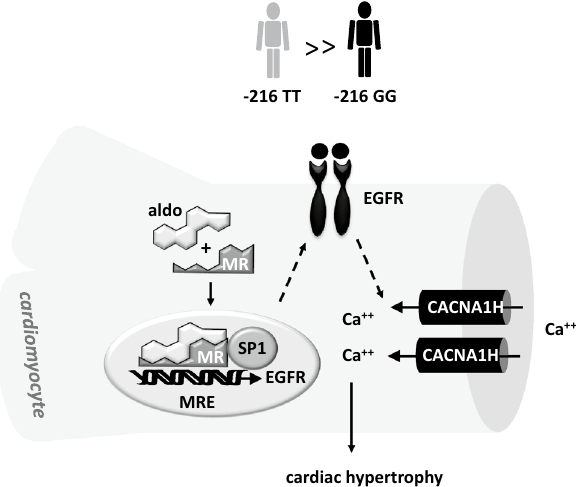
Figure 7. Proposed model linking cardiac MR activation and SNP-216 (T/T) to enhanced EGFR and CACNA1H expression and changes in cardiomyocyte